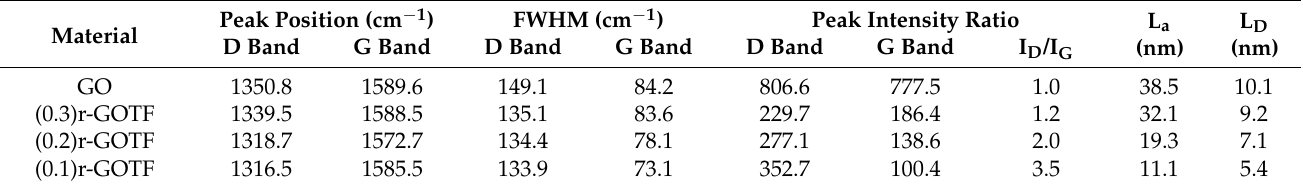
Table 2. Raman characteristic peak positions, I D /I G values of GO-based composite